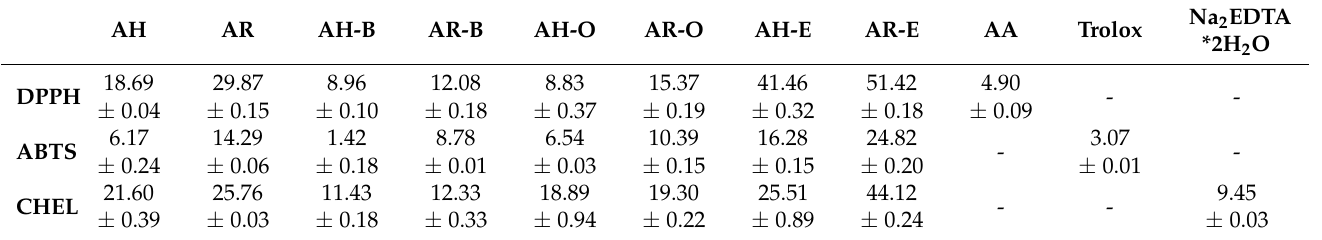
Table 3. The DPPH • and ABTS • + radical scavenging activity, and metal chelating (CHEL) activity of various extracts of A. acutiloba